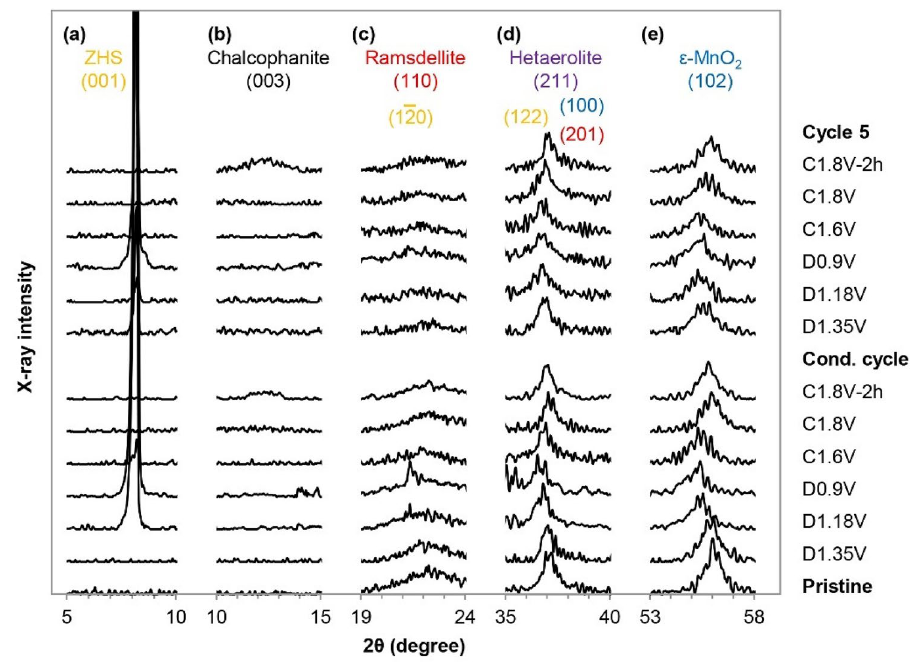
Figure 4. XRD patterns of EMD electrodes at different potentials during GCD tests with the conditioning cycle at 0.5 mA cm –2 and the 5th cycle at 1 mA cm –2 . The chosen peak ranges are representive of ( a ) ZHS, ( b ) chalcophanite, ( c ) ramsdellite, ( d ) hetaerolite, and ( e ) ε-MnO 2